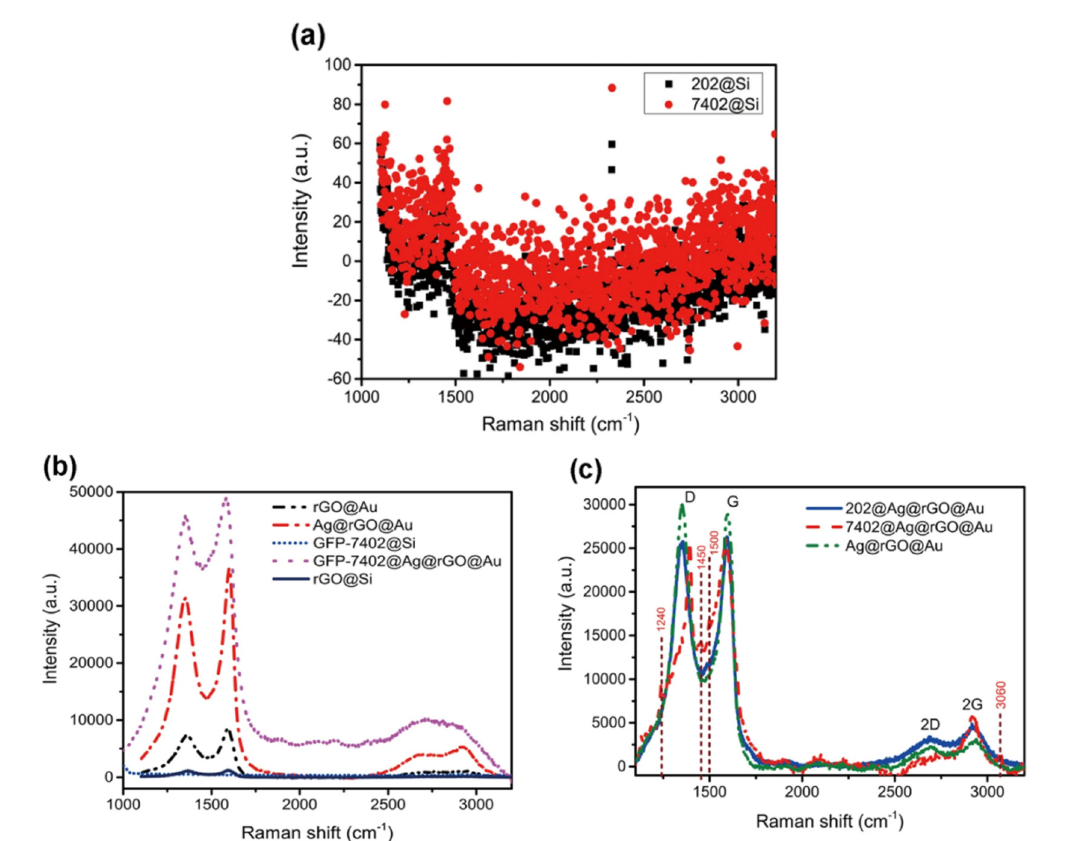
Figure 15. Identification and detection of tumor cells via SERS of Ag-RGO-Au. ( a ) Conventional Raman spectra of tumor cells (7402, red circle) and normal live cells (202, black square) on the silicon slide, which are indistinguishable in the vibration information. ( b ) Raman spectra of RGO on Si slide, RGO on Au nanostructures, GFP labeling tumor cells on Si slide, GFP labeling tumor cells on G-SERS substrate and G-SERS substrate. ( c ) Raman spectra of the same tumor cells (7402, red dash line), normal live cells (202, blue solid line) in ( a ) on our G-SERS substrate (green dash dot line). Reprinted with permission from Ref. [202].Copyright 2016, Springer Nature.